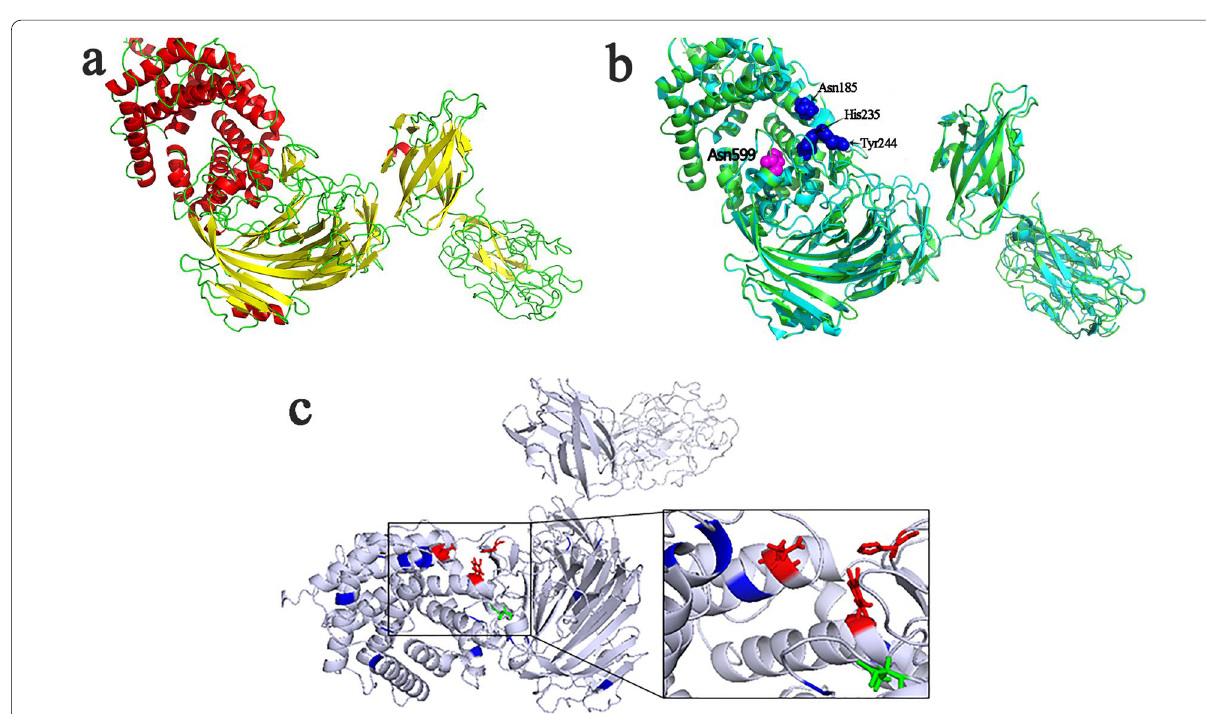
Fig. 4 Three-dimensional structure of Ec Xly visualized by PyMOL. a Secondary structures of Ec Xly: α-helix (red); β-sheet (yellow); random coil (green). b The structural alignment between Ec Xly (green) and PXL (cyan). The catalytic residues were shown in blue sphere and the glycosylation site was shown in magenta sphere. c Structural elements around the active sites. Tryptophan residues were colored in blue. The catalytic residues were colored in red rod. The glycosylation site N599 was highlighted in green rod. The picture in the black box was a close-up view of the catalytic residues of Ec